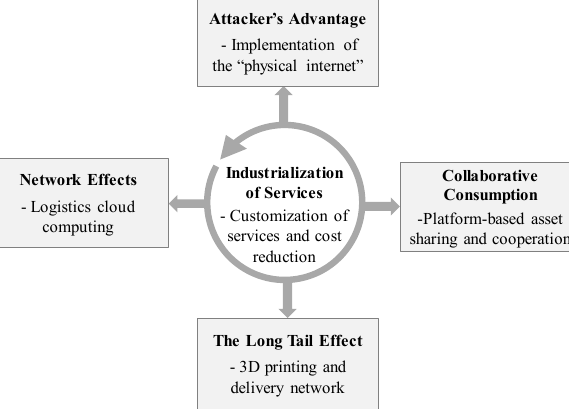
Figure 7. Elaboration of opportunities for 3PL arising from digital disruptions. The logic counter to the industry analysis is indicated by arrows pointing from the inside out.